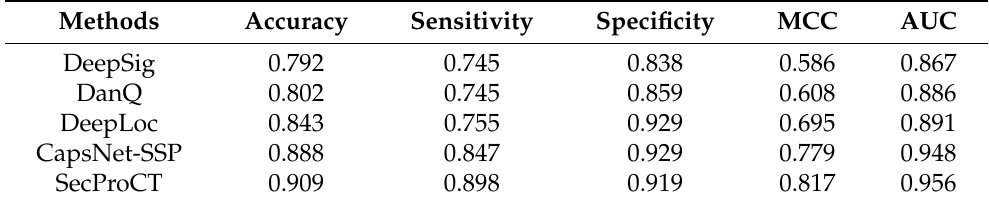
Table 5. Performance comparison with deep learning architectures for predicting saliva-secretory proteins.